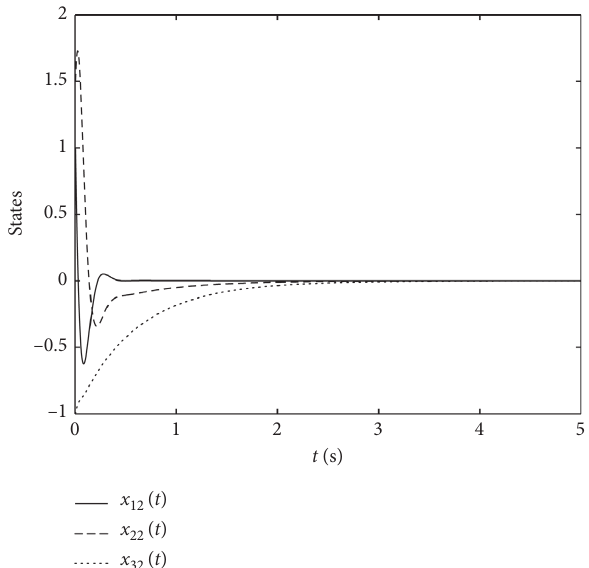
Figure 5: Control results of the fractional order nonlinear interconnected